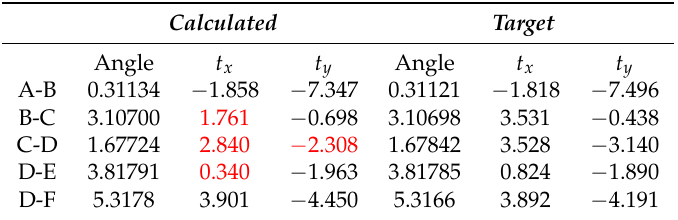
Table 3. Parameters obtained by our approach before ICP refinement. Significant errors are colored in red. Angles are in radians and translation distances are in